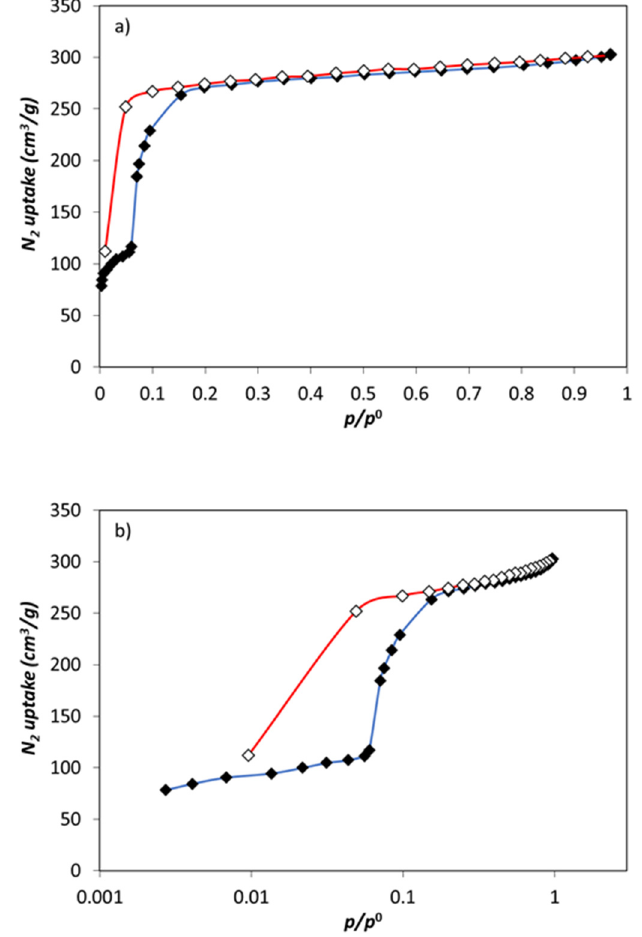
Figure 4. N 2 adsorption equilibrium isotherm at 77 K on Zn(dcpa) in linear ( a ) and log ( b ) scales. Filled and empty symbols represent the adsorption and desorption data, respectively.